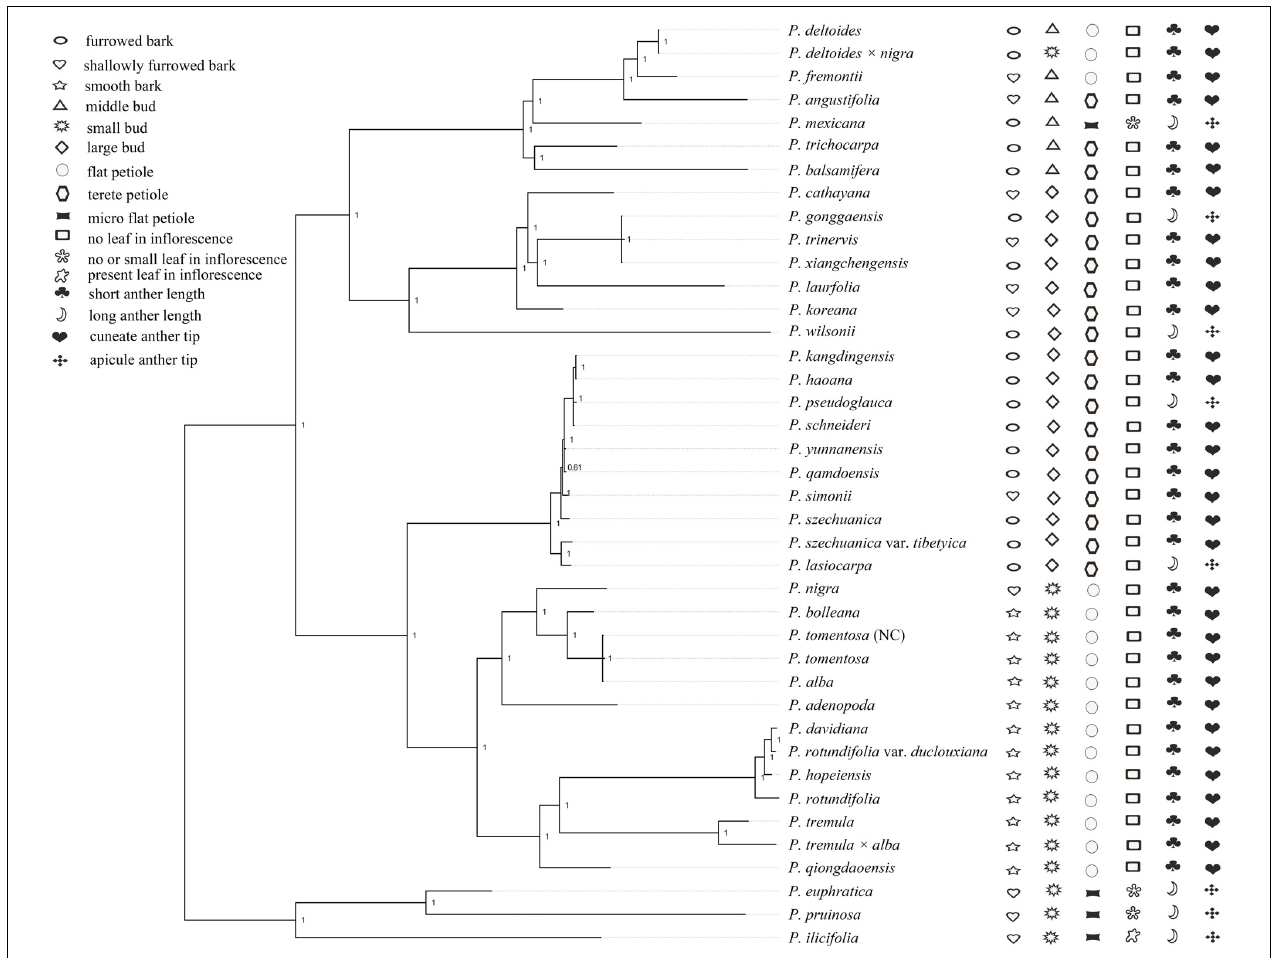
FIGURE 6 | Morphological character reconstruction of Populus on the Bayesian phylogenetic tree.